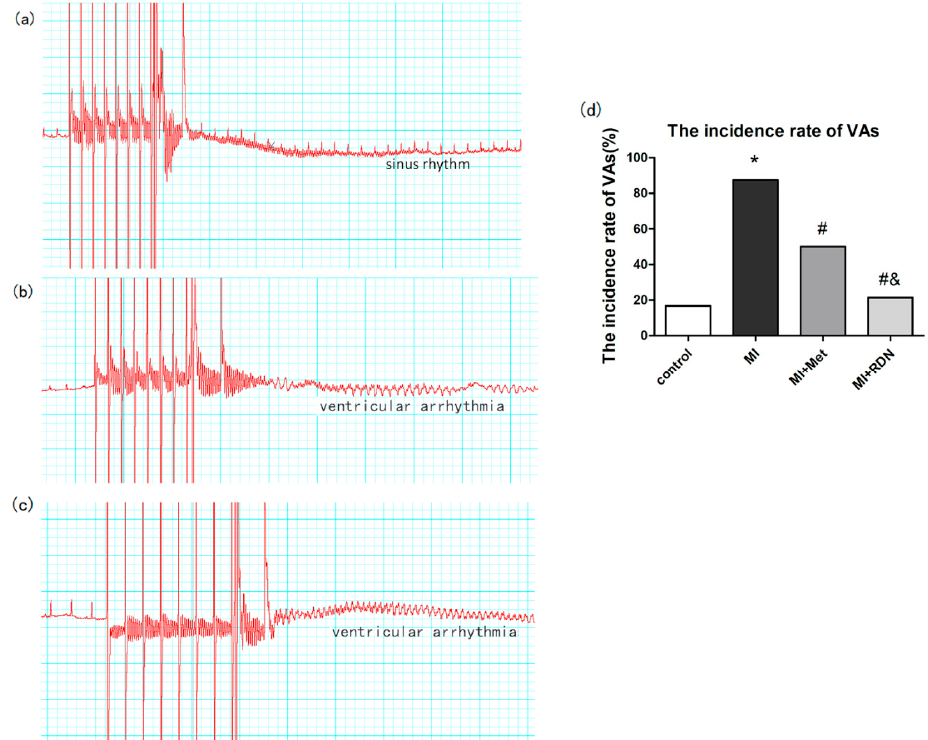
Figure 5. RDN significantly reduced the incidence of ventricular arrhythmias. Representative ECG of electrical stimulation, including sinus rhythm ( a ), ventricular arrhythmias ( b ) and ( c ). Ventricular arrhythmias were less easily induced in RDN group rather than in MI group and Met group ( d ). (* p < 0.05 vs. Control group; # p < 0.05 vs. MI group; & p < 0.05 vs. Met group). MET = metoprolol. MI = myocardial infarction. RDN = renal denervation [97].